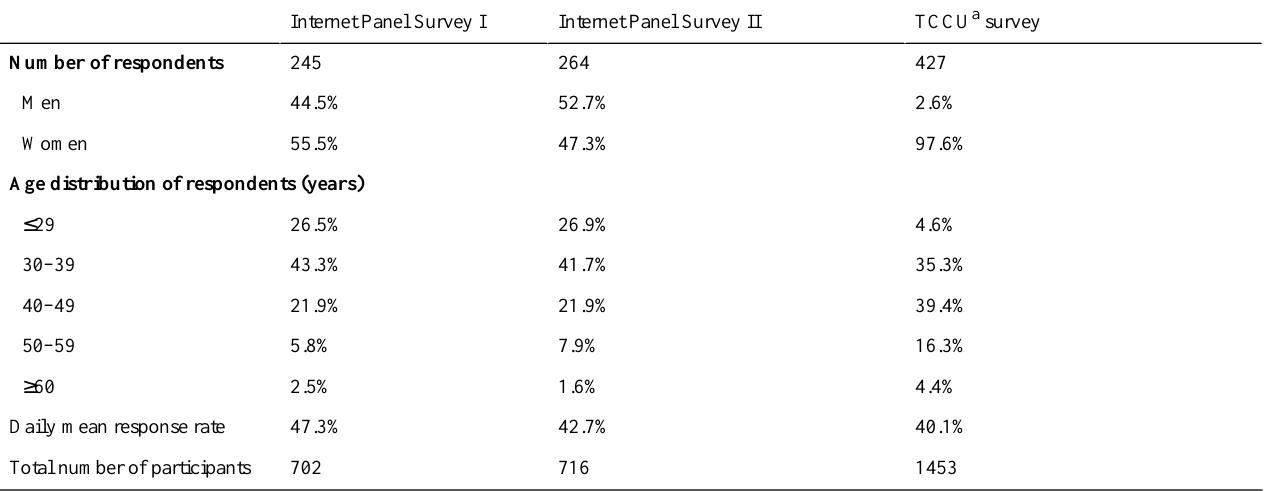
Table 2. Demographics and response rates of participants in the three